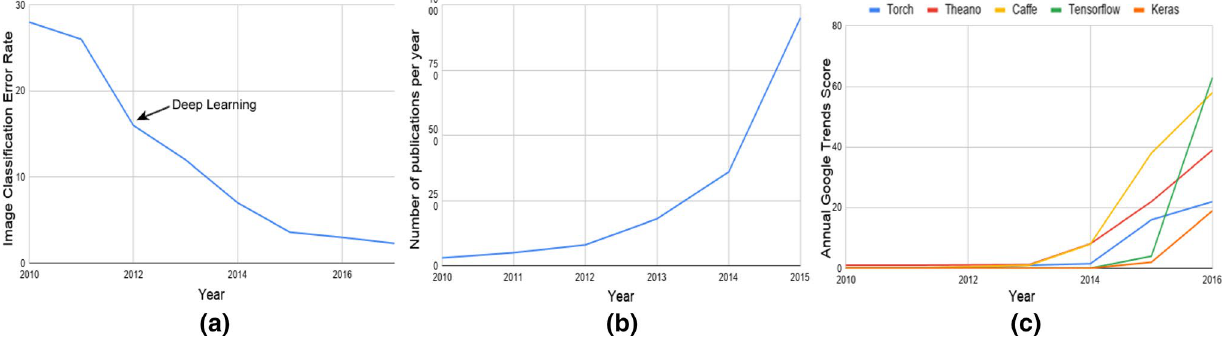
Fig. 1 Facts about deep learning. a The improvement of the image classification rate after the introduction of the AlexNet deep neural net- work. b The increasing number of publications as indexed by ISI (International Scientific Indexing). c The popularity (Google Trends Score) of major deep learning software packages in the current decade: Torch, Theano, Caffe, TensorFlow, and Keras [24]. Elaborated by the authors of this